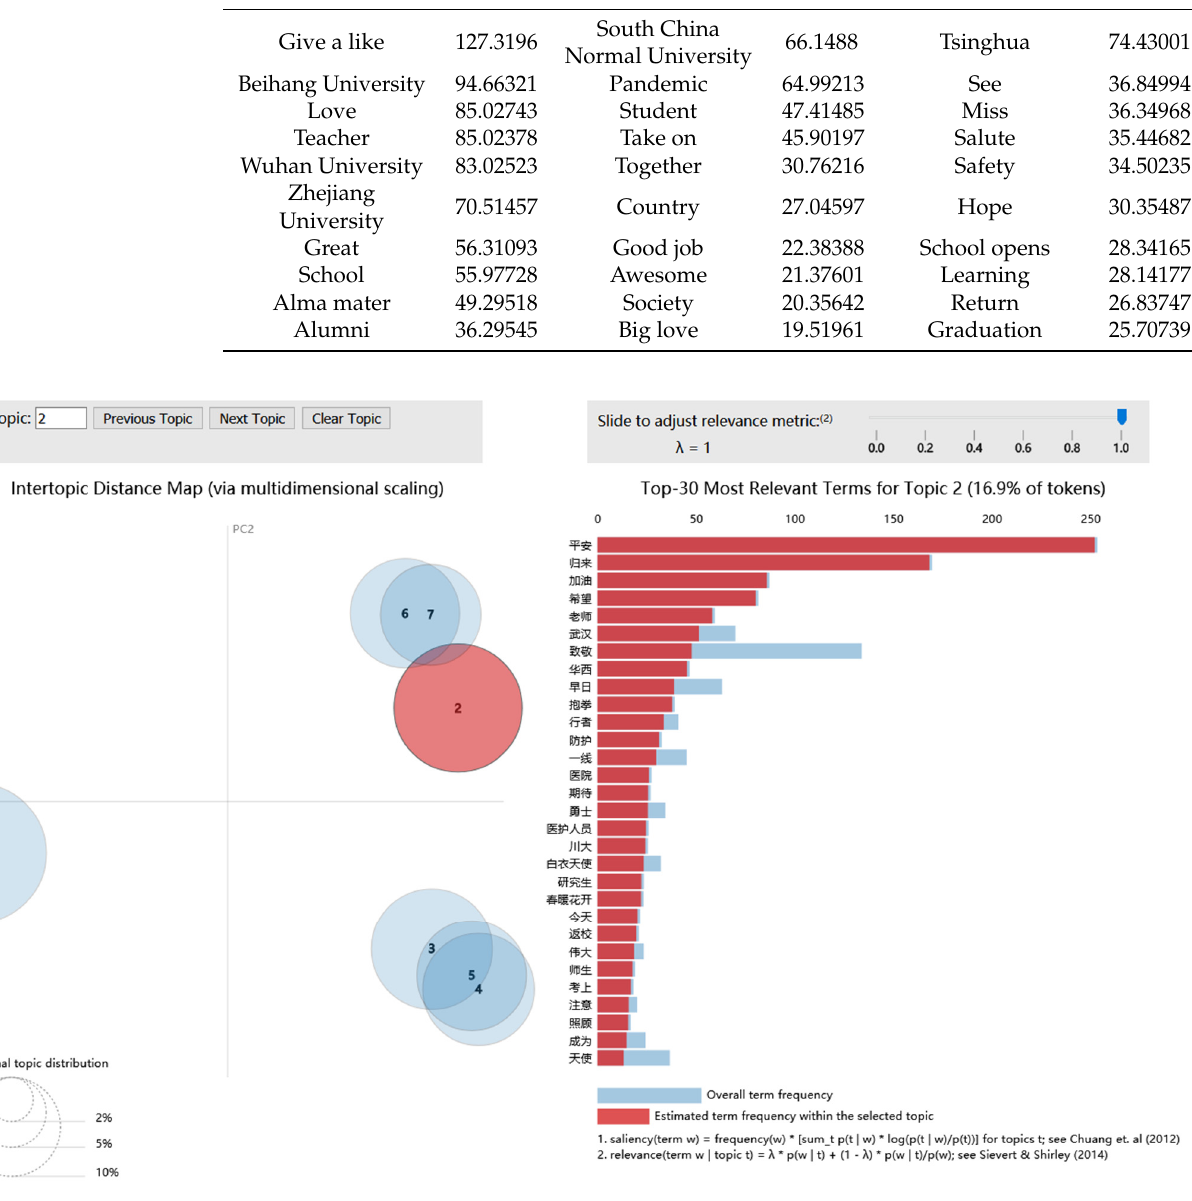
Figure 8. Visualization results of pyldavis Library.